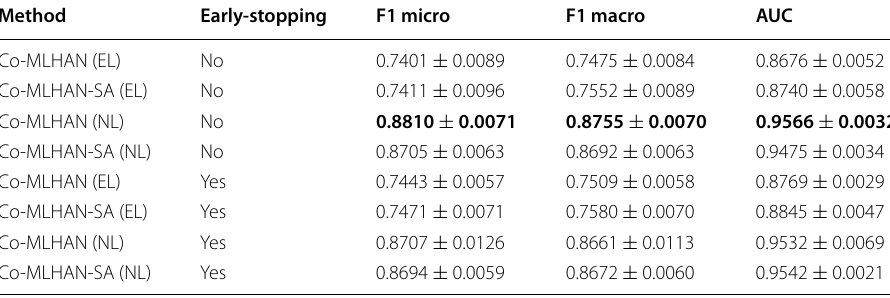
Bold values refer to the best score for each criterion